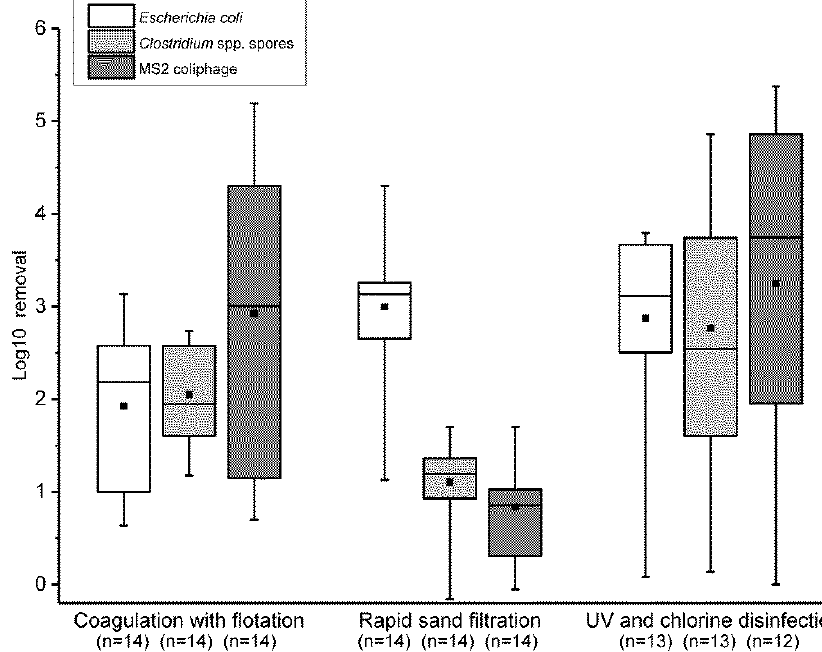
Figure 2. Log 10 removals of Escherichia coli , Clostridium spp. spores, and MS2 coliphages in PWW of three test series after coagulation with flotation, rapid sand filtration, and UV and chlorine disinfection presented as boxplot including mean (small box), median (line), and range. n = number of samples.